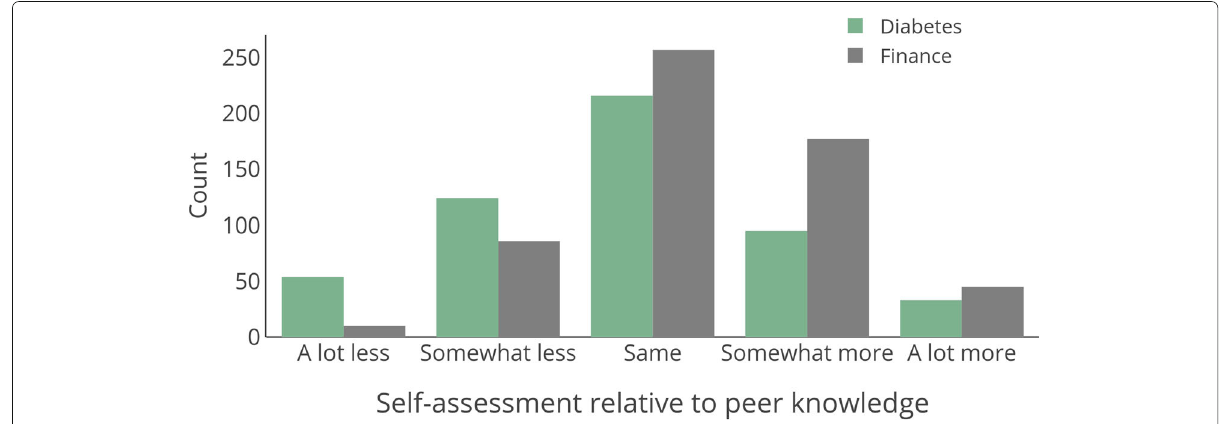
Fig. 8 Self-assessment of knowledge in two domains